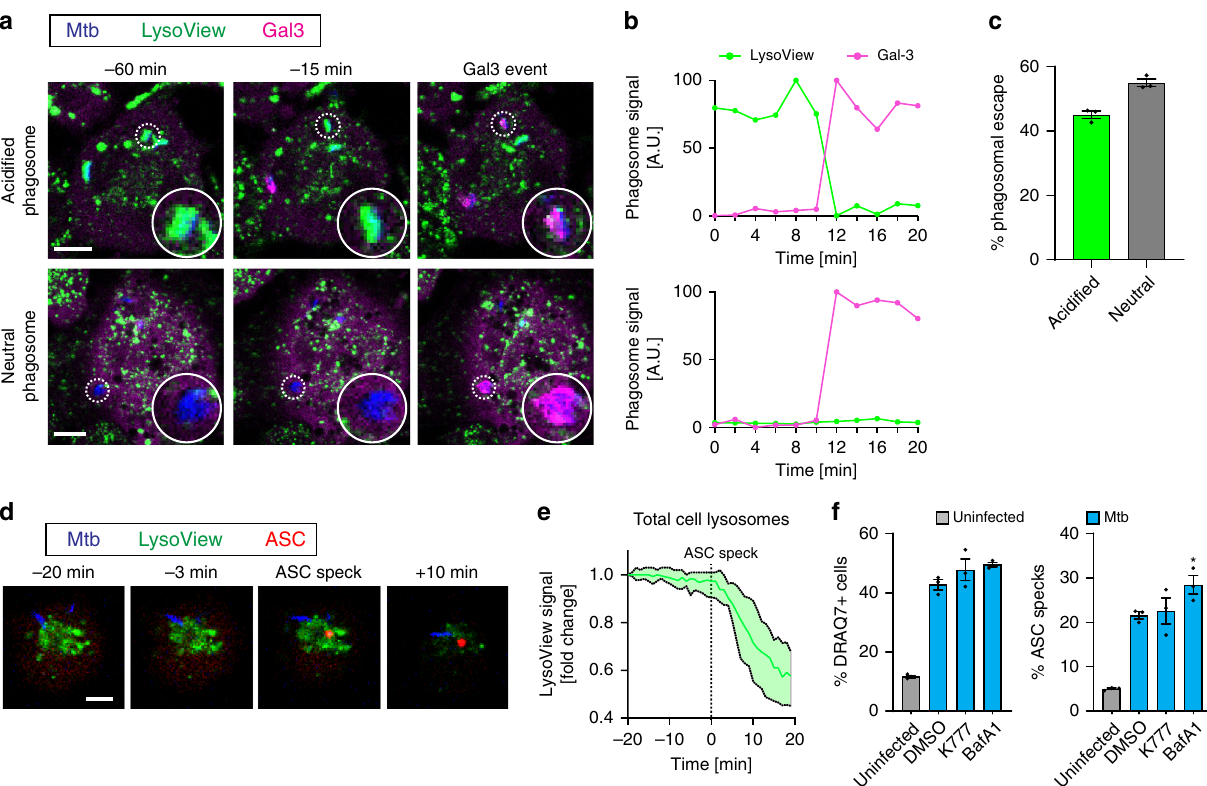
Fig. 5 In fl ammasome activation by Mtb is independent of lysosomal damage and release of active cathepsins. THP1-Gal3-mScarlet (magenta) macrophages were labelled with a marker of acidi fi ed lysosomes (LysoView633, green), infected with Mtb-BFP (blue) and imaged by time-lapse confocal microscopy for 24 h. a Representative images, with circular insets showing bacteria that cause Gal-3 recruitment to their acidi fi ed or neutral compartment, respectively. b Traces of Gal-3 and LysoView signals for the Mtb phagosomes highlighted in ( a ). c Quanti fi cation of the occurrence of Gal-3 events on acidi fi ed (LysoView + ) and neutral (LysoView – ) Mtb phagosomes. n = 282 Mtb phagosomes analysed from 3 independent experiments. d Representative images of ASC-speck formation in THP1-ASC-GFP (red) cells labelled with LysoView633 (green) infected by Mtb-BFP (blue). Data representative of three independent experiments. e Quanti fi cation of the average LysoView signal in single cells before and after ASC-speck formation. n = 27 cells analysed, median± IQR shown. f THP1-ASC-GFP macrophages were treated with DMSO, pan-cathepsin inhibitor K777 or the inhibitor of lysosomal acidi fi cation BafA1 and infected with Mtb H37Rv. After 24 h, ASC specks and DRAQ7 + cells were quanti fi ed for n > 2000 cells per condition, and the data were analysed by one-way ANOVA with two-sided Dunnett ’ s test. Mean± s.e.m. shown, * p < 0.05. Data representative of three independent experiments. All scale bars 10 µ m. Source data are provided as a Source Data fi